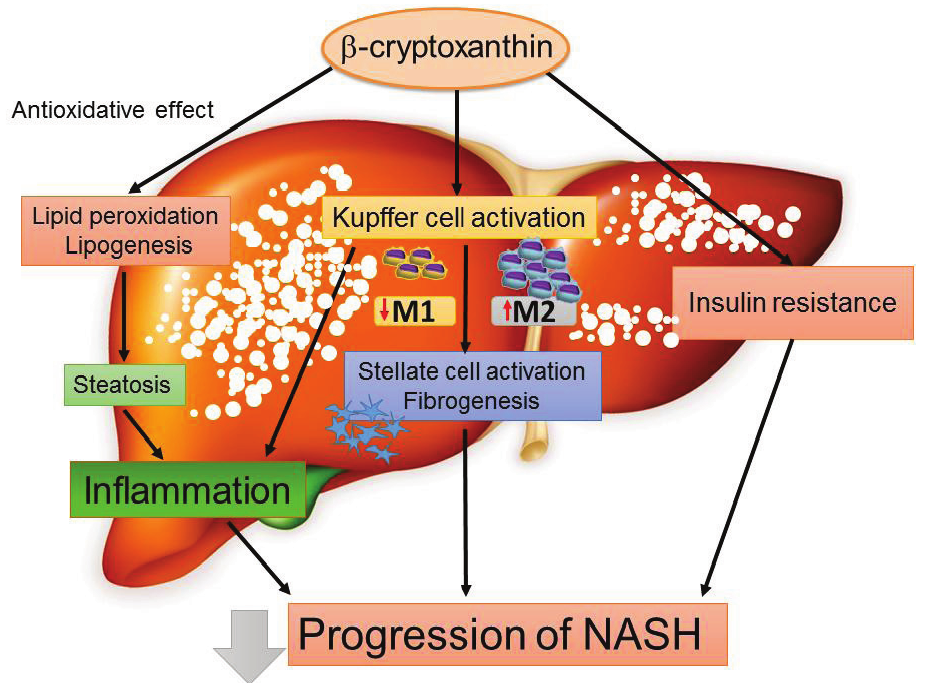
Figure 3. Beneficial effects of β - cryptoxanthin on the progression of NASH. β -Cryptoxanthin, an antioxidant carotenoid, inhibits the progression of NASH by attenuating lipid accumulation, lipid peroxidation, and insulin resistance. Furthermore, β -cryptoxanthin decreases numbers of M1 macrophages while increasing those of M2 macrophages, which results in